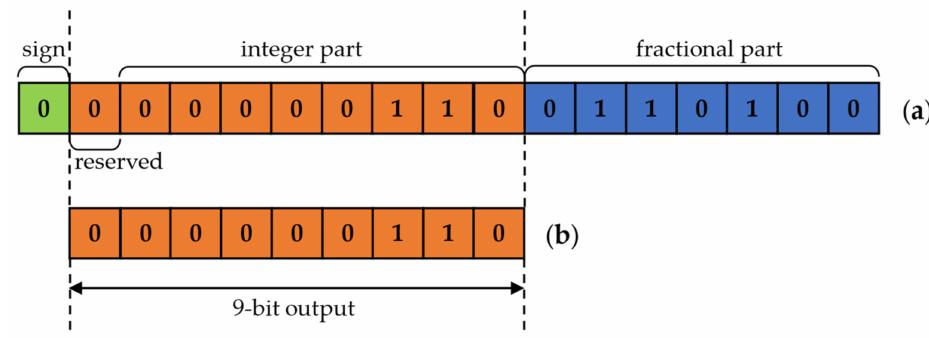
Figure 9. An example: ( a ) output data before truncation; ( b ) output data after truncation. This truncation method not only ensures lower accuracy loss, but it also saves trans- mission bandwidth. All output data form an output feature map that is used as input to the next